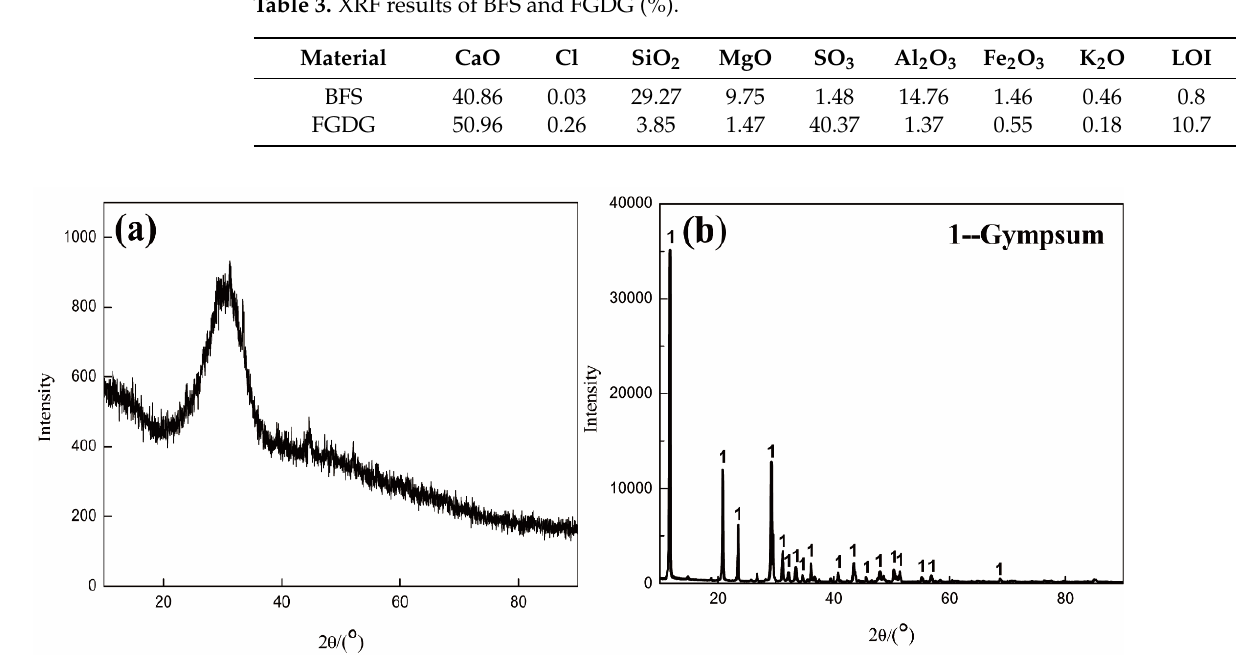
Figure 2. XRD spectra of ( a ) BFS and ( b ) FGDG.